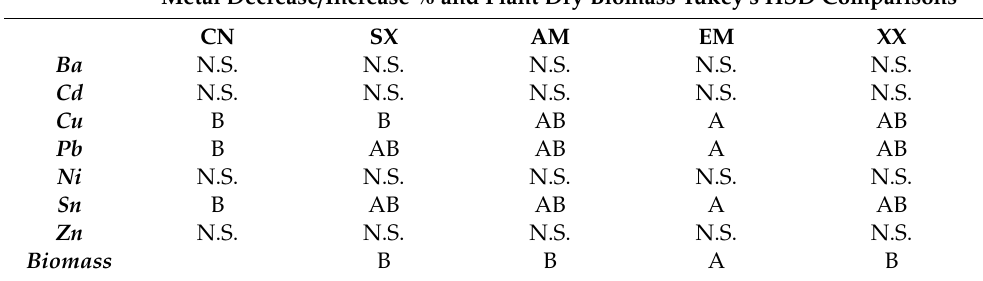
Within each row, treatments not sharing a letter are significantly ( p < 0.05) di ff erent. N.S. = Not significant. CN = Non-planted control; SX = Willow non-inoculated; AM = Willow + AMF inoculation; EM = Willow + ECM inoculation; XX = Willow + AMF + ECM EM = Willow + ECM inoculation; XX = Willow + AMF + ECM inoculation.